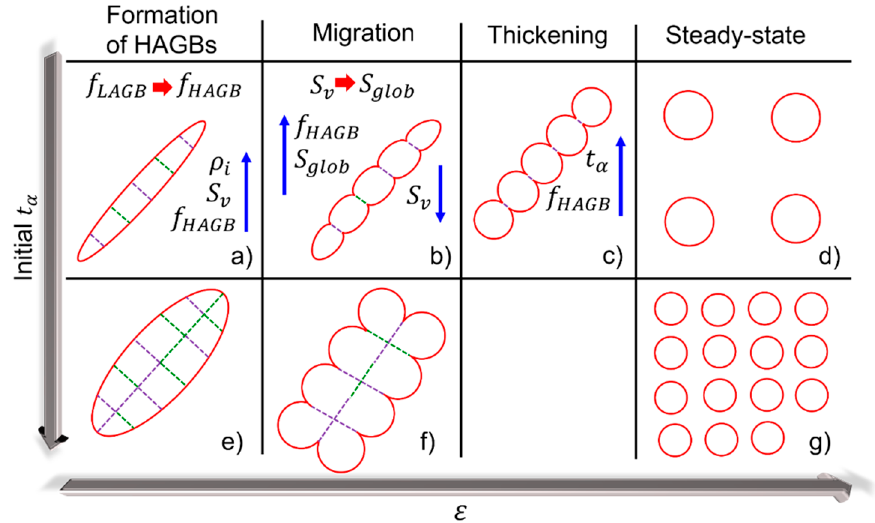
Figure A1. Schematic representation of the dynamic globularization of the α -phase for thin ( a – d ) and thicker ( e – g ) α -platelets: ( a , e ) formation of HAGBs within the α -phase; ( b , f ) migration of α / β interfaces though formed boundaries within the α -phase; ( c ) thickening of the formed particles; ( d , g ) formation of dispersed and globular α